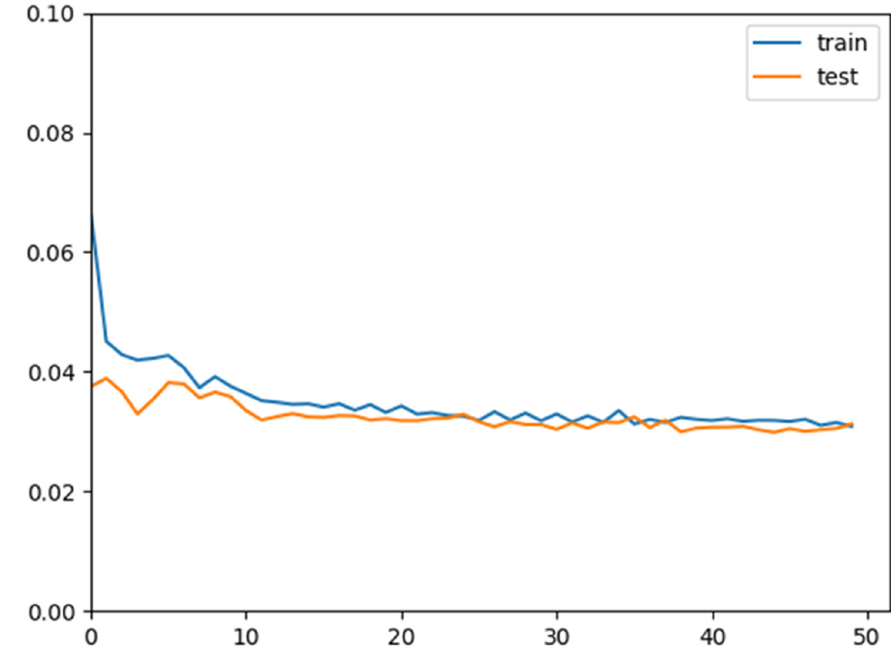
Figure 13. Bee IN training phase. Electronics 2022 , 11 , x FOR PEER REVIEW